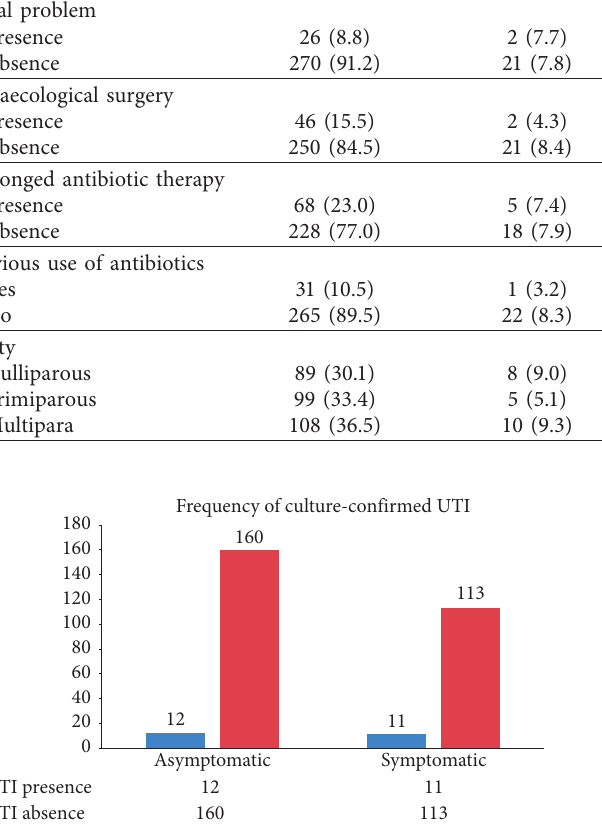
Figure 1: Symptomatic and asymptomatic UTI among pregnant women attending ANC at HUCSH, Southern Ethiopia, from March to June 2019.